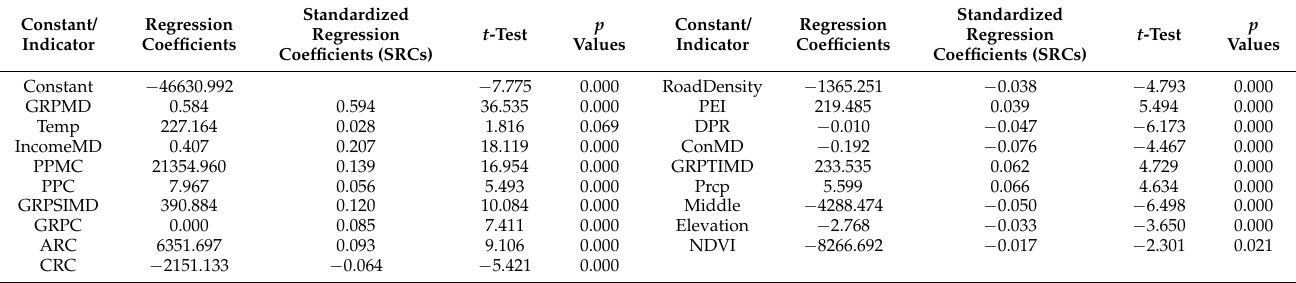
Table 3. Multiple linear regression model for overall assessment.